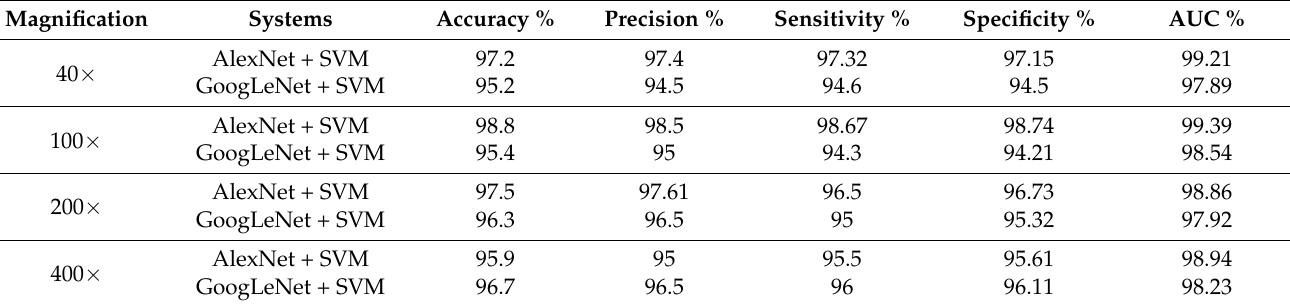
Table 4. Results of the hybrid technology for HI diagnosis for early detection of BC.